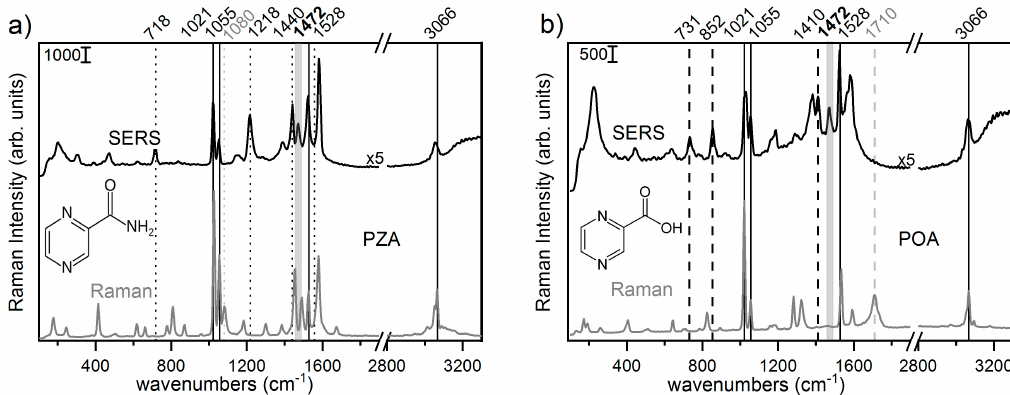
Figure 1. Reference Raman spectra of the powder (gray spectra in the bottom) and surface-enhanced Raman spectroscopy (SERS) spectra (black spectra in the top), applying hydroxyl amine hydrochloride reduced h-AgNPs, of PZA and POA in a concentration of 10 − 3 M in panel ( a ) and ( b ), respectively. Marker bands for both analytes are indicated with black lines, marker band specific for PZA are depicted with doted lines, marker band for POA with dashed lines. For both analytes a scheme of the molecular structure is shown.